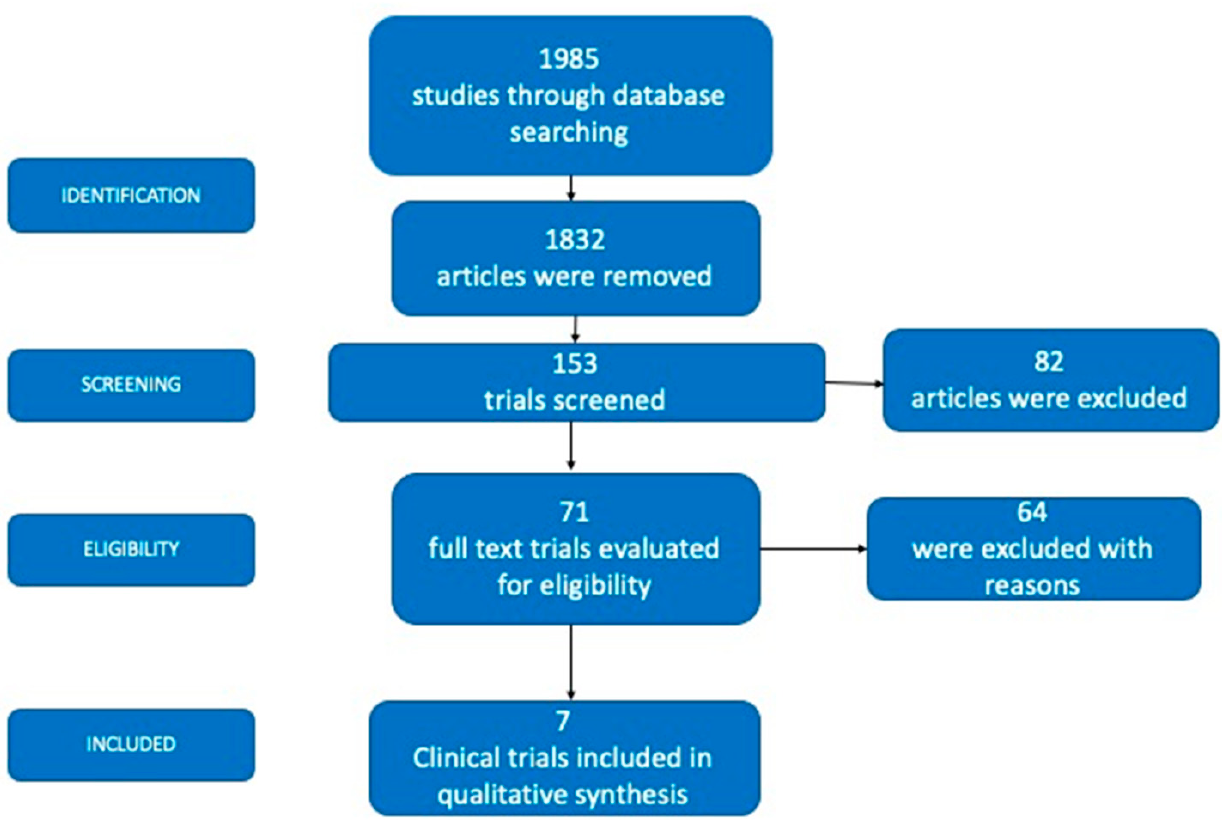
Figure 1. Flow chart of the study selection method.